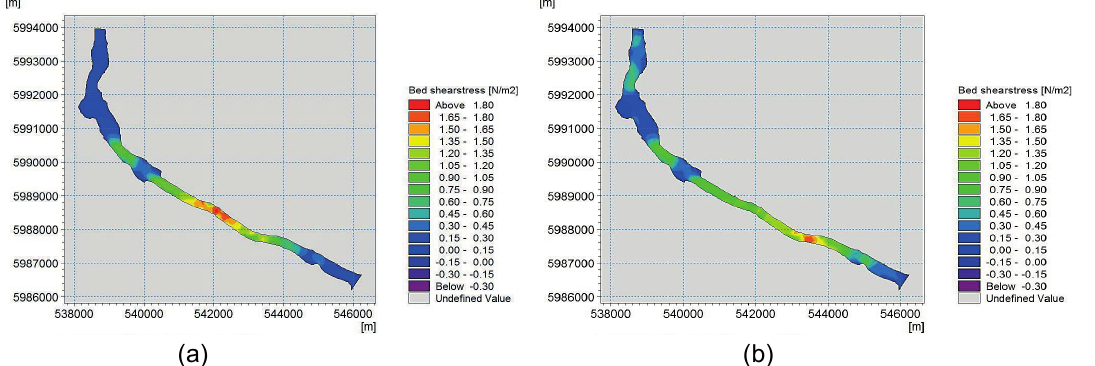
(a) (b) Fig. 8 Max event shear stresses in the 8-Mile channel due: (a) to currents, (b) to a combination of current and waves.